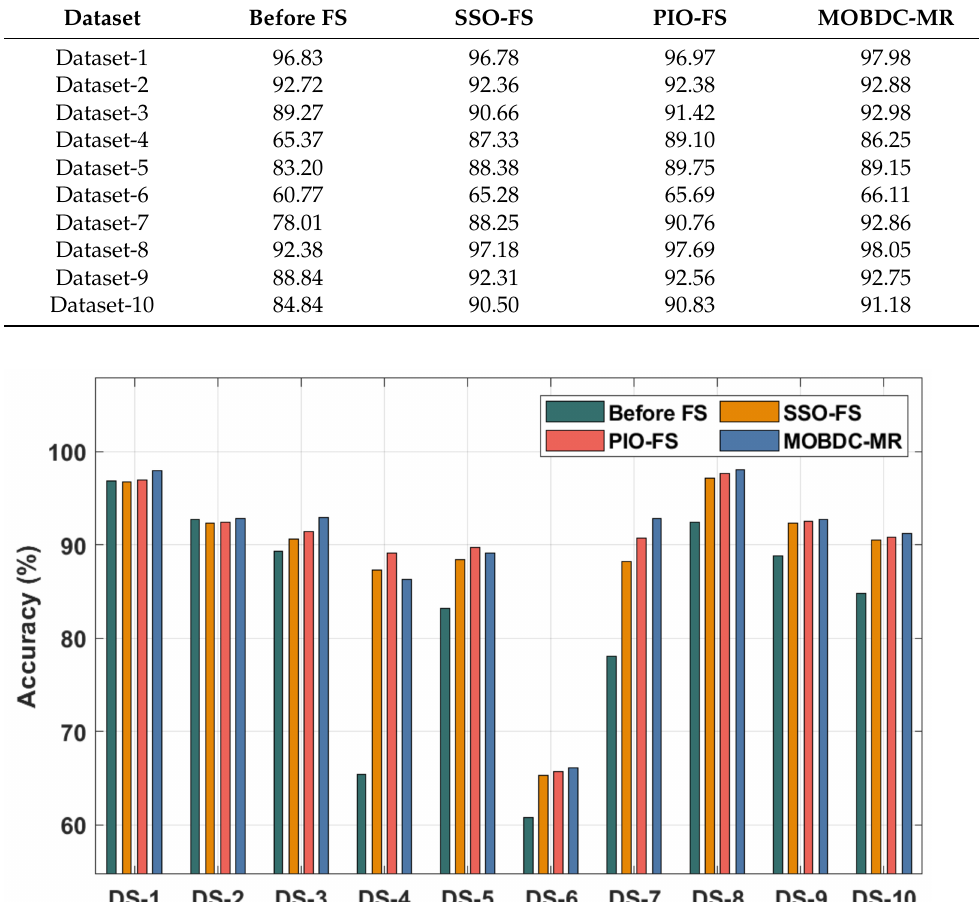
Table 4. Results of the various feature selection methods in terms of accuracy.